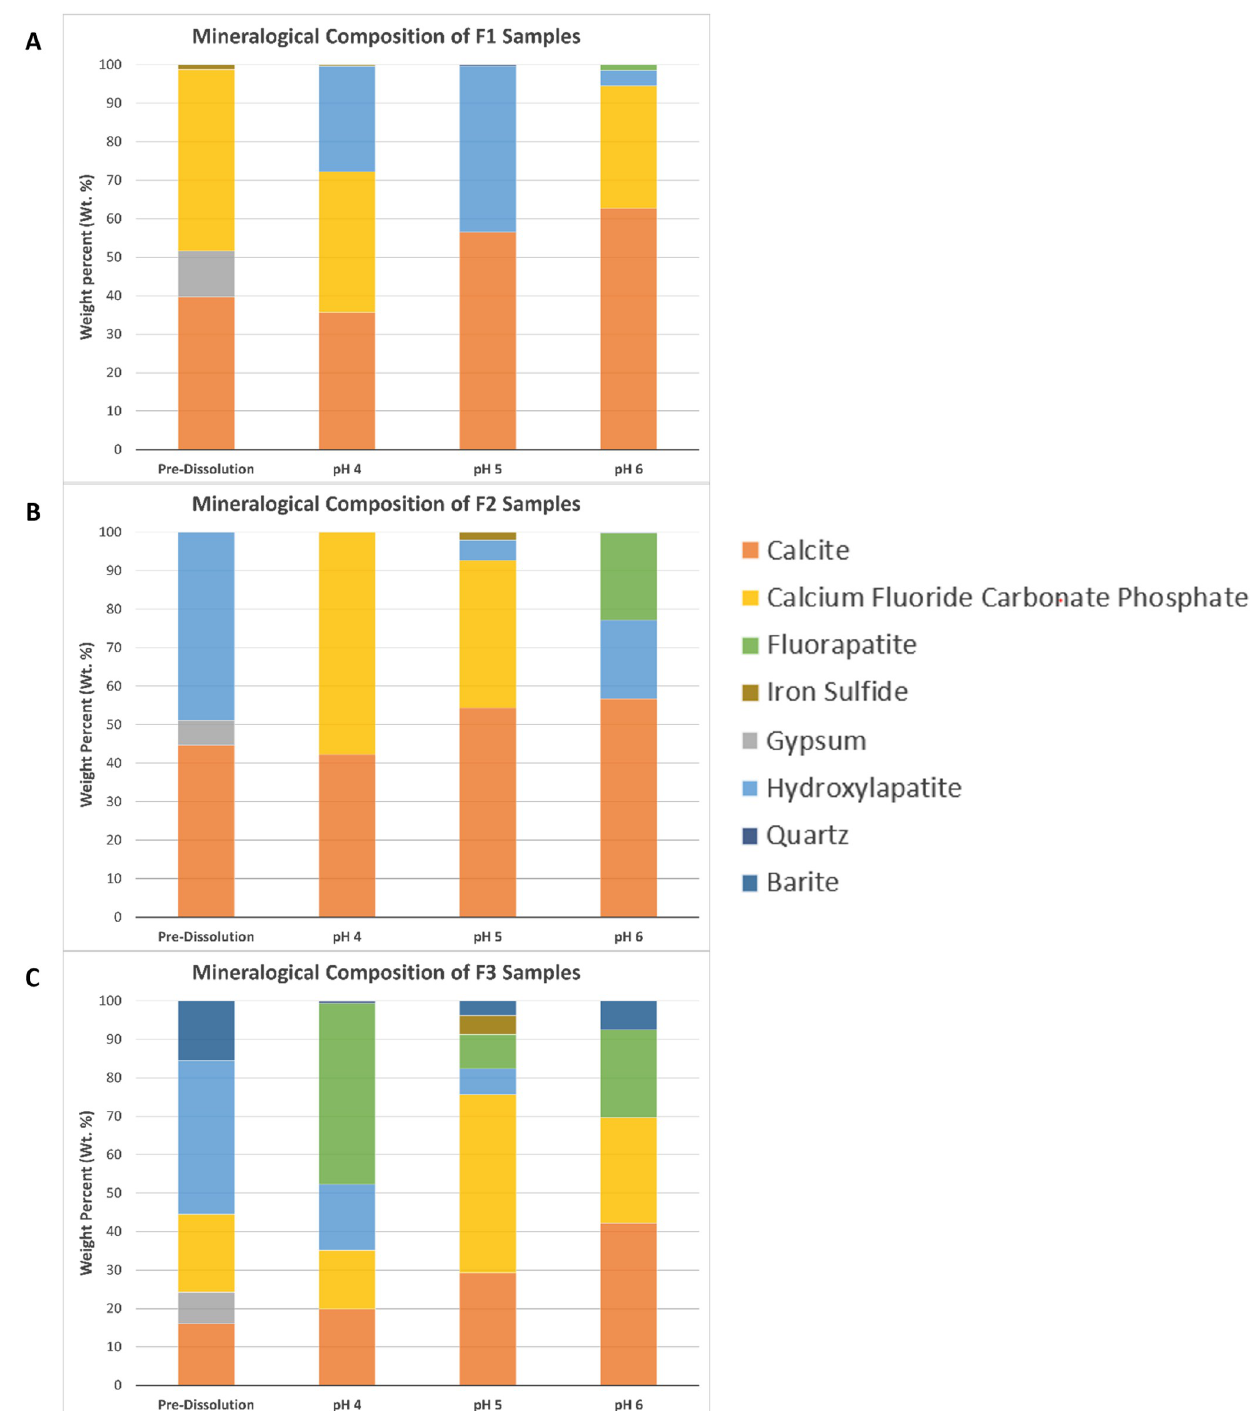
Fig 3. Bar graph of fossil mineralogical composition. Mineralogical composition of pre- and post-dissolution fossils based on XRD analyses. (A) F1 samples; (B) F2 samples; (C) F3 samples.